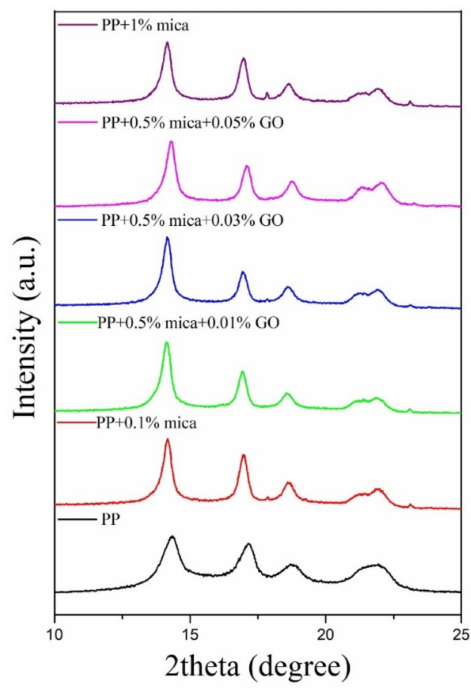
Figure 5. The X-ray diffraction patterns of polypropylene, mica/polypropylene and graphene oxide/mica/polypropylene